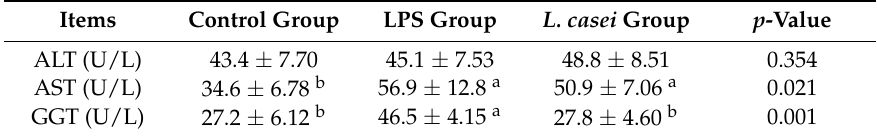
Table 2. Effects of dietary supplementation with L. casei on activities of ALT, AST, GGT in the piglet plasma.